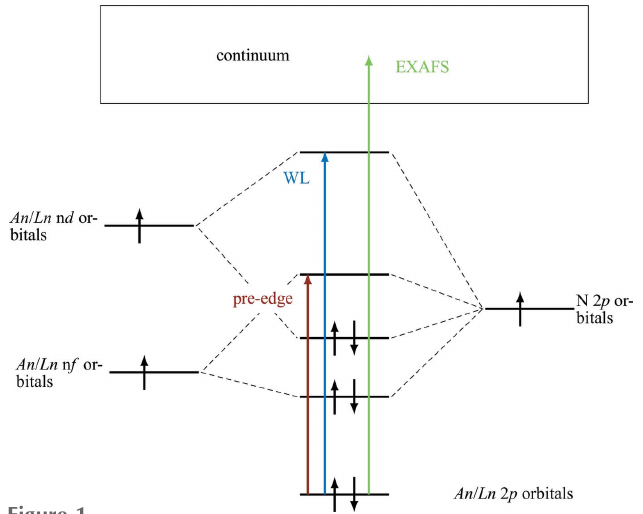
Figure 1 Simplified MO scheme of An/Ln bound to N and the excitations causing the pre-edge (red), WL (blue) and EXAFS (green) features observed in An/Ln L 3 -edge spectra.